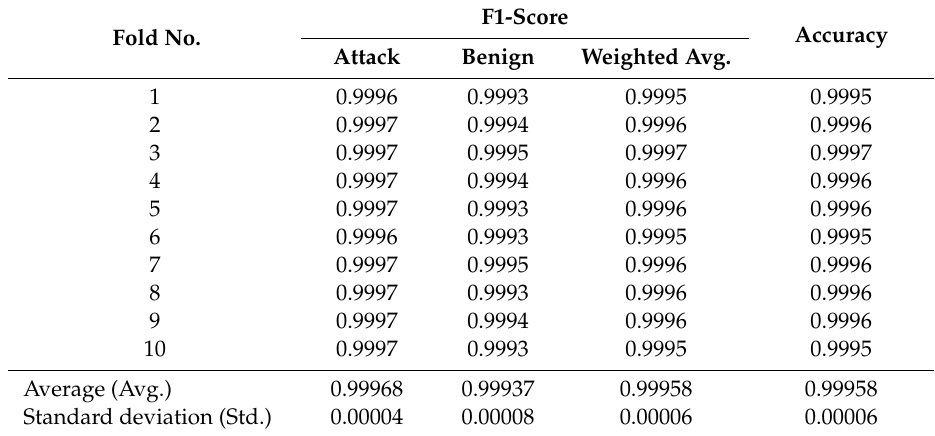
Table7. F1-scoresandaccuracyresultsofthe10-foldcross-validationforattackandbenignclassifications using the selected feature numbers.